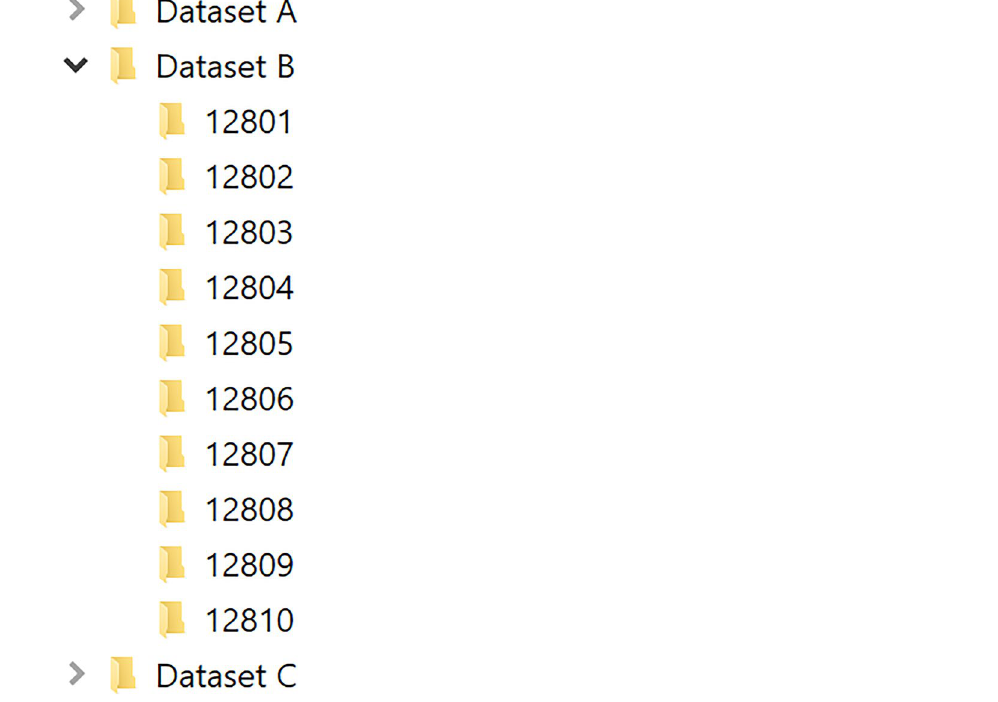
Figure 3. Correct folder structure for recordings. The recordings folder “Recordings/Dataset B” should contain all of the recordings to be exported. Each of the numbered subfolders (12801–12810) should contain the recording data for one measurement.